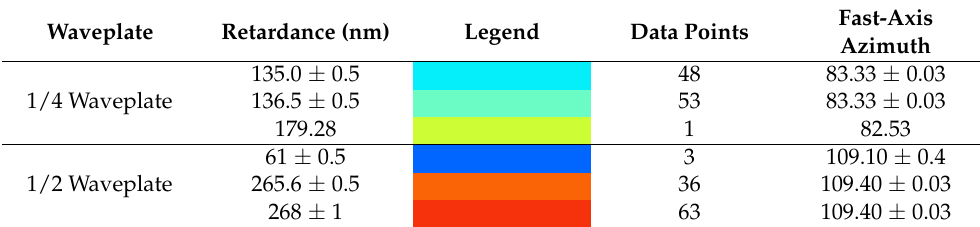
Table 2. The 532 nm waveplate parameter measurements.